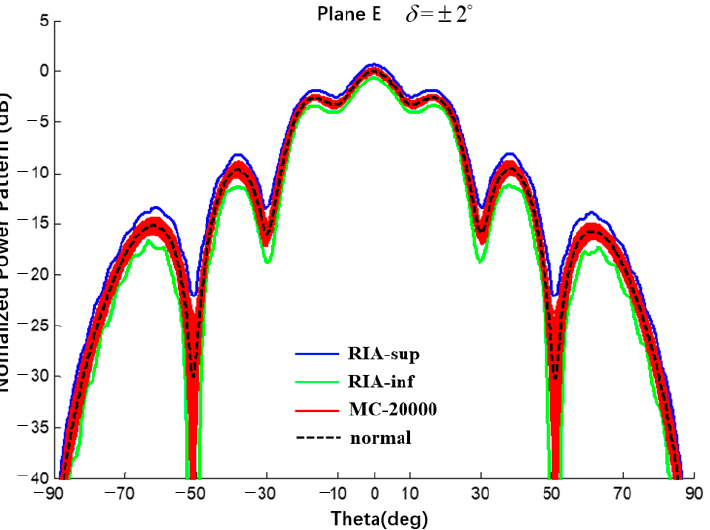
Figure 22. Interval power pattern of excitation phase error of spherical CAAs (Plane E, uniform excitation, the tolerance of MC method is ±2°). Table 6. Numerical results of SLL of power pattern in Figures 21 and 22.